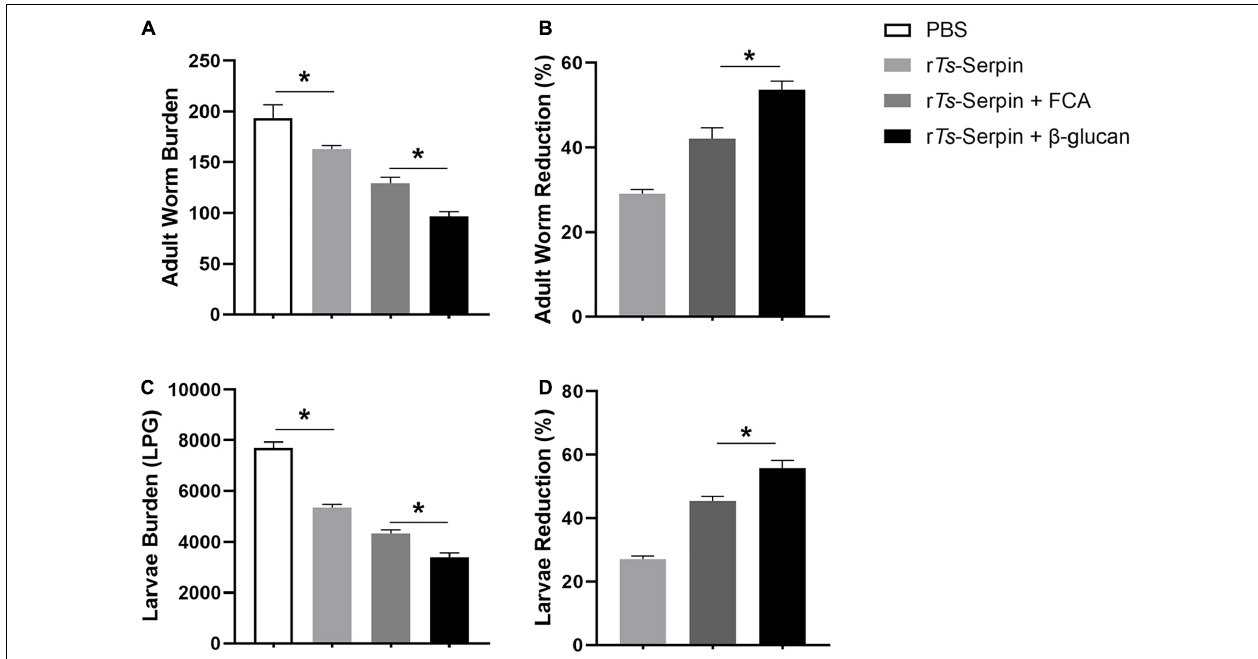
FIGURE 1 | Helminth burden in the immunized mice. (A) The number of adults recovered from intestines from immunized mice after challenge with 500 ML of T. spiralis . (B) The reduction rates of adult worms were analyzed based on the mean number of adult worms. (C) The number of muscle larvae (ML) per gram (LPG) in skeletal muscles from immunized mice after challenge with 500 ML of T. spiralis . (D) The reduction rates muscle larvae were analyzed based on the mean number of recovered muscle larvae per gram (LPG) of muscle from vaccinated groups compared with PBS group. Results are expressed as the mean ± SD of 10 mice per group. The data shown are representative of three independent experiments. * P < 0.05 as indicated by the line (Tukey multiple comparison following ANOVA).